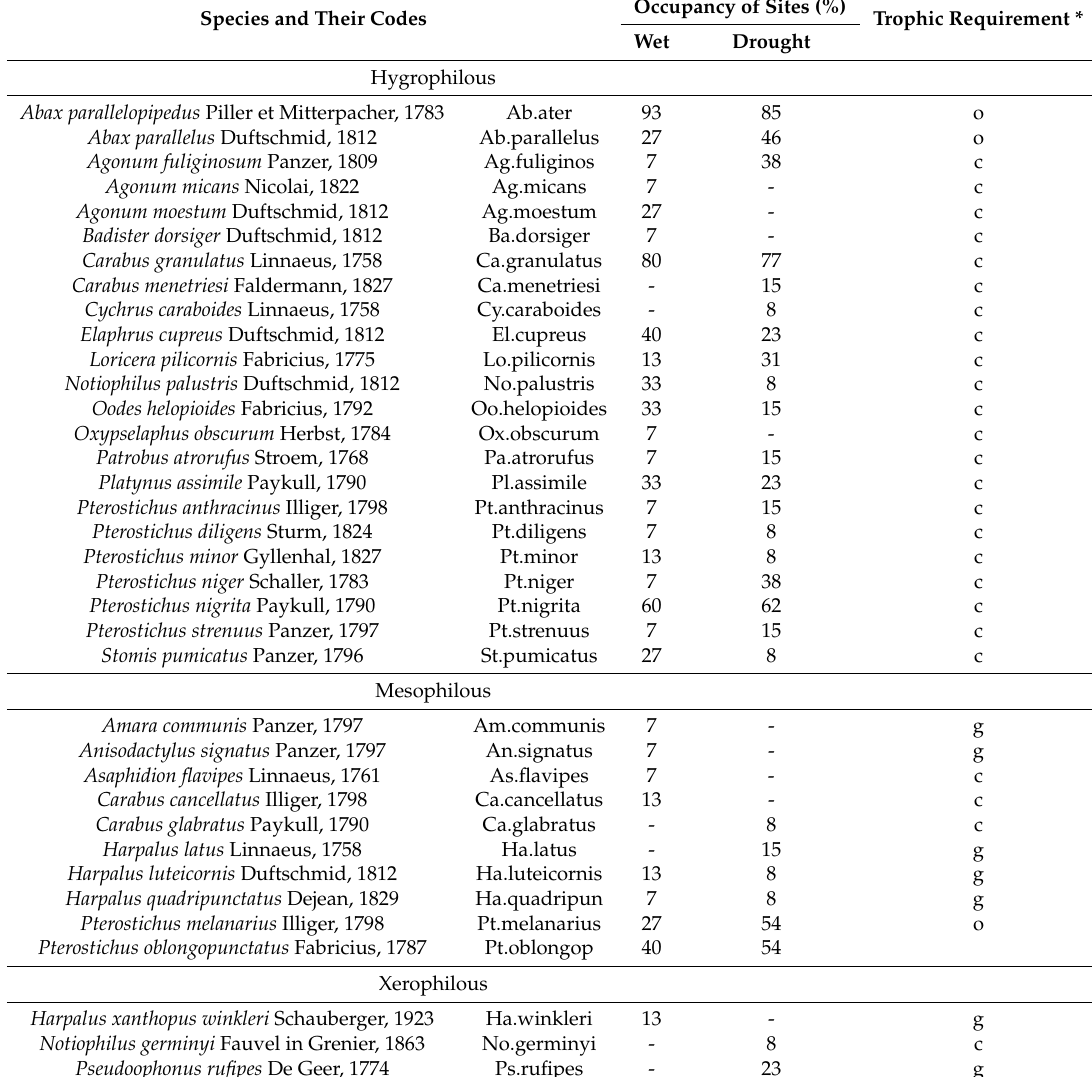
Table 1. Carabid beetle species caught in the study area, the percentage occurrence of each species in sites in the wet and drought weather conditions and information regarding their trophic requirement and humidity preference. Species grouped according to their